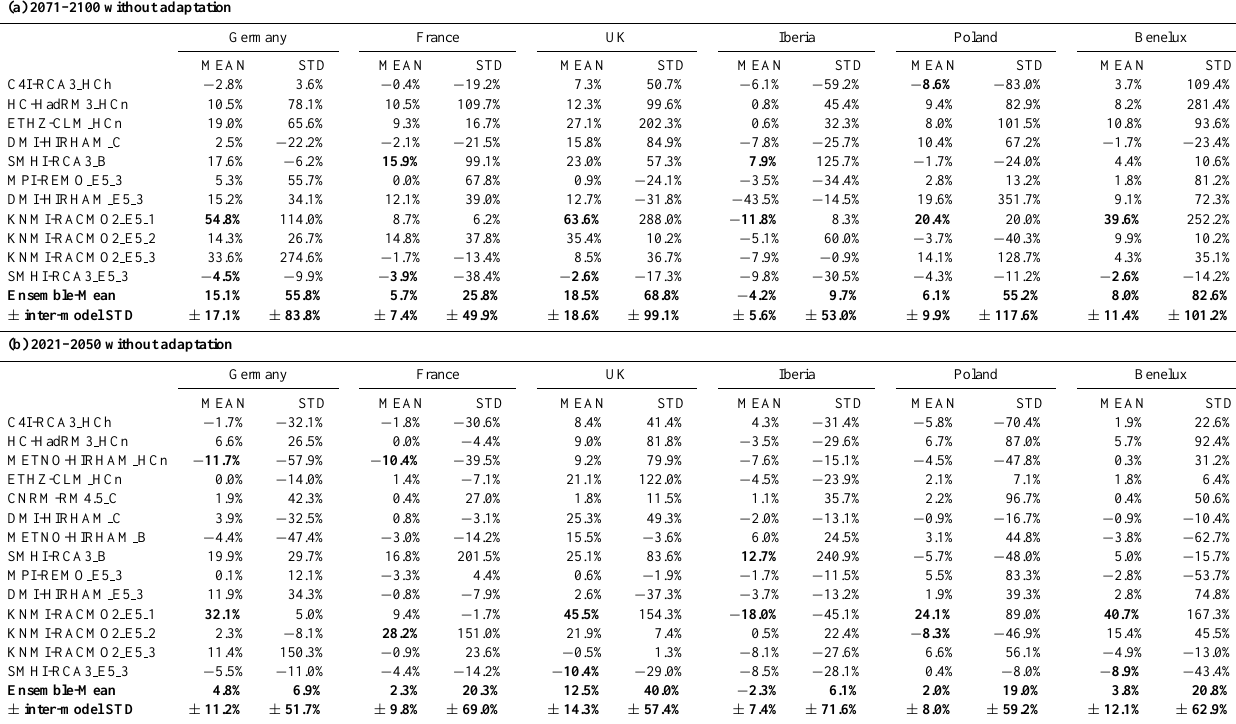
Table A2. ACC signal of losses calculated in the individual RCM scenario simulations. Change signals A1B-20C without adaptation of the loss threshold for the 2 future periods in the middle (2021–2050) and at the end of 21C (2071–2100). For each region, the maximum and minimum changes of mean loss ratios (indicating the maximum spread of the ensemble) are highlighted using bold